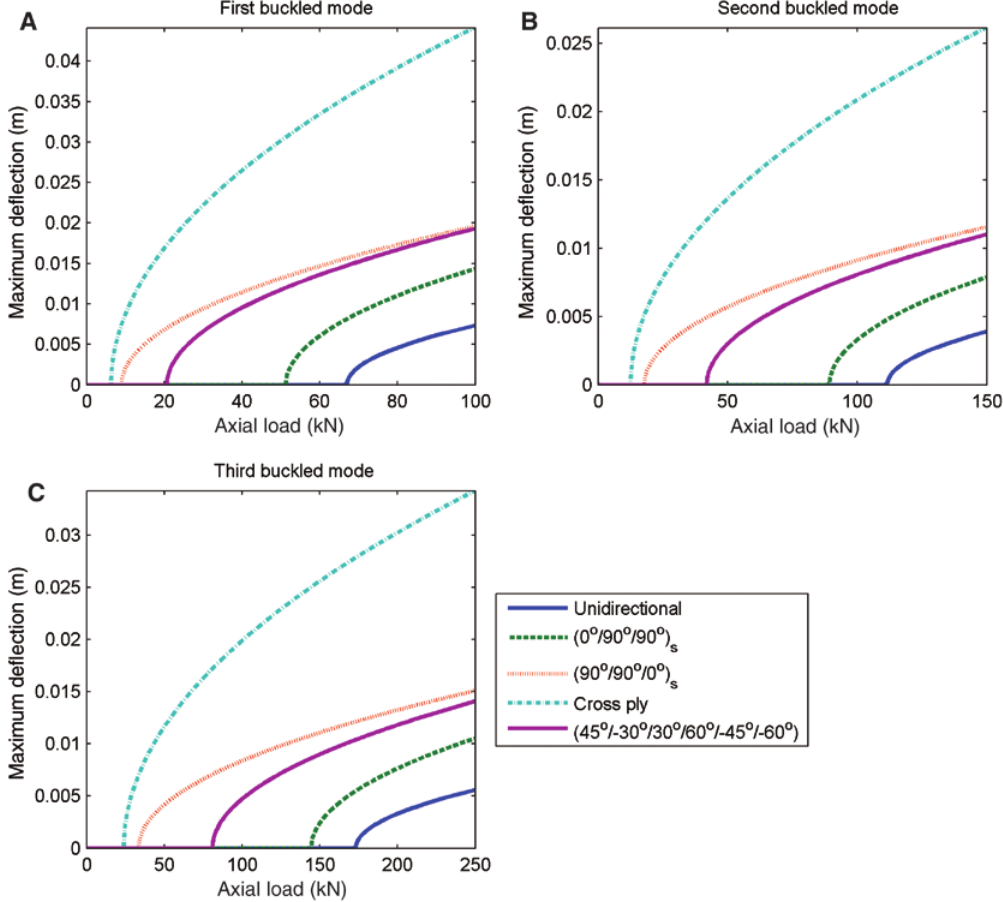
Figure 3 Static bifurcation diagrams of the first three buckled configurations for different laminates of a CC beam.